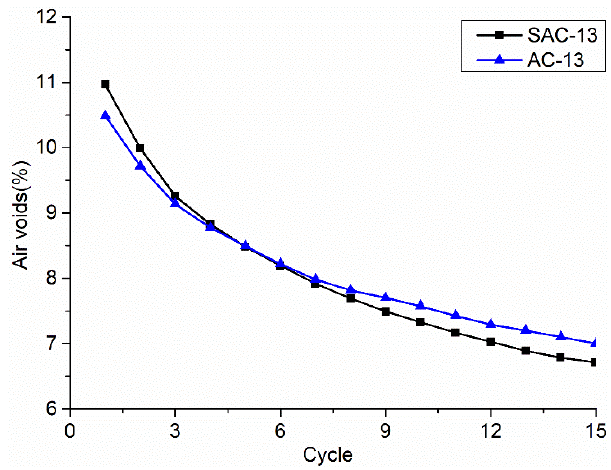
( b ) Figure 10. Model parameters and temperature curves with load cycle times; ( a ) σ es and T curves with load cycle times; and, ( b ) η 1 curves with the load cycle times.